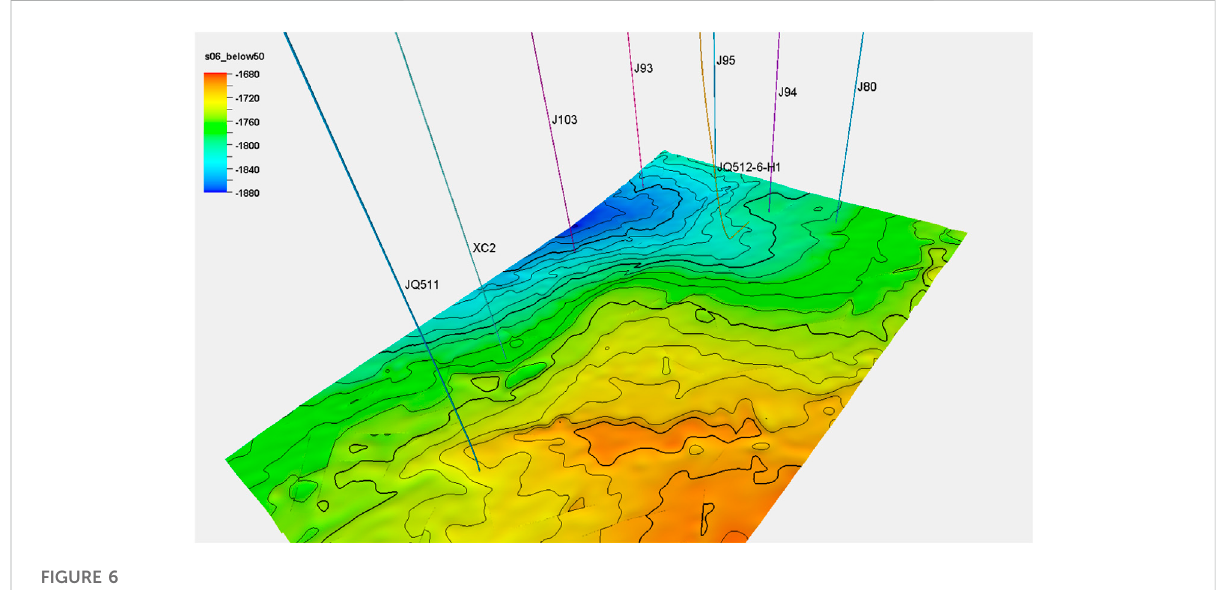
FIGURE 6 Correction of 3D structural plane by geological guidance comparison results.